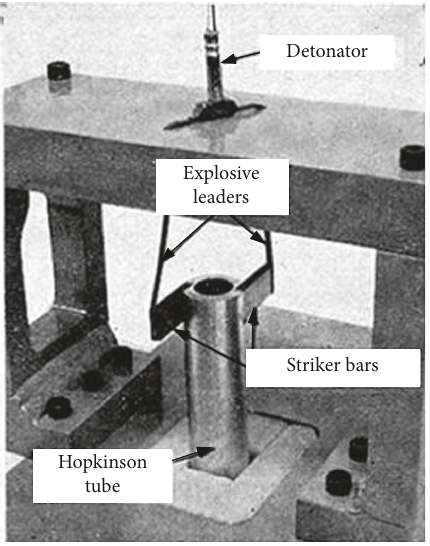
Figure 6: Explosive loading TSHB designed by Duffy et al. [40].